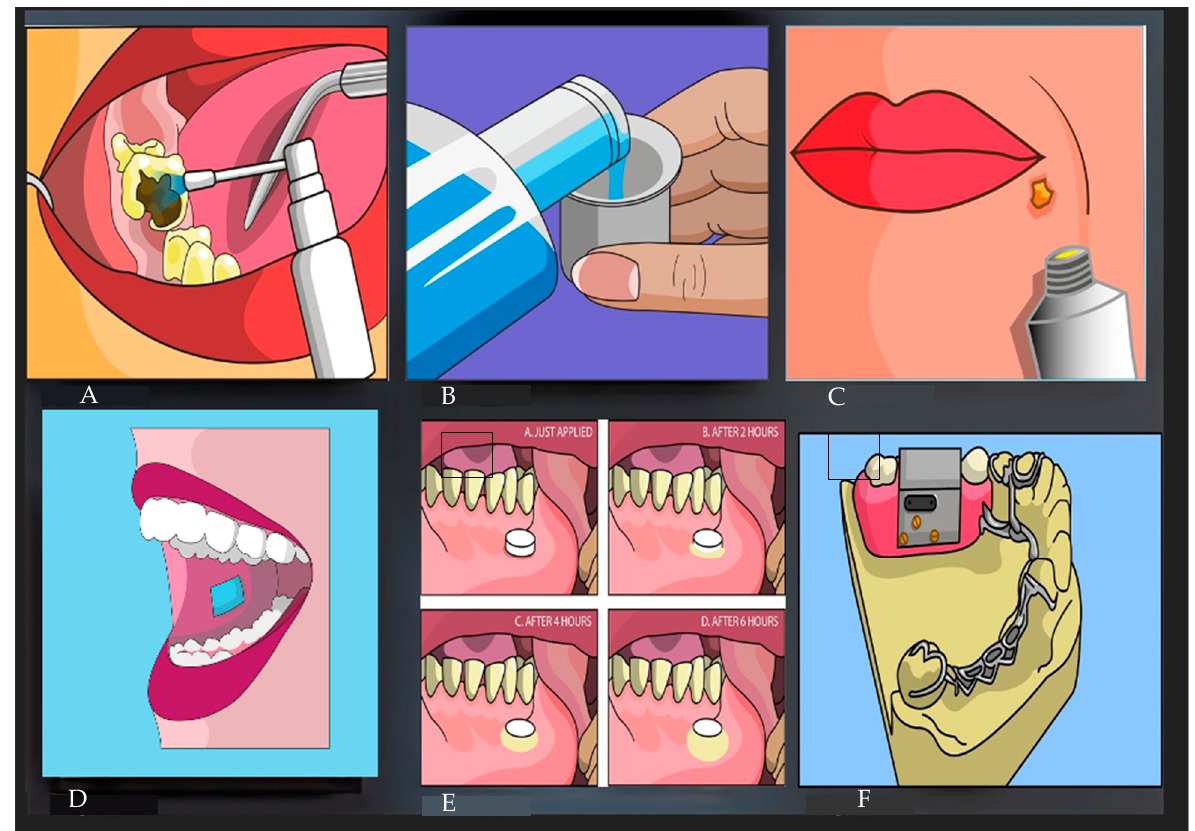
Figure 1. It shows different subtypes of Transbuccal Drug Delivery Systems: ( A ) buccal spray: a uniform dispersion of active ingredient in a suitable solvent along with propellant; ( B ) therapeutic mouth rinse: viscous liquid that contains drugs; ( C ) ointment: a semisolid dosage form in which the active ingredients are dispersed in a bioadhesive ointment base; ( D ) patch: made of silicone foil consisting of an impermeable carrier layer and reservoir containing the drug; ( E ) tablet: a small disc applied to the mucosa of the cheek; ( F ) IntelliDrug: a mechatronic approach, incorporated within a prosthesis.